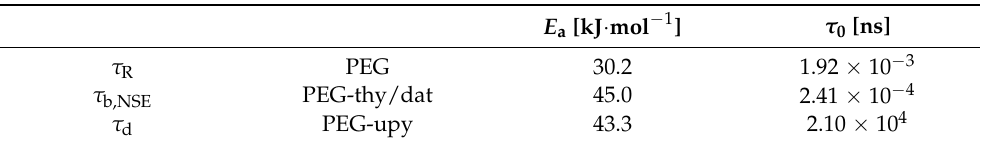
Table 8. Fitting parameters of the temperature dependence of the Rouse time, τ R for PEG and the network detachment relaxation time, τ d for PEG-upy using Equation (6). The fitting parameters for τ b,NSE for PEG-thy/dat taken from [18] is also